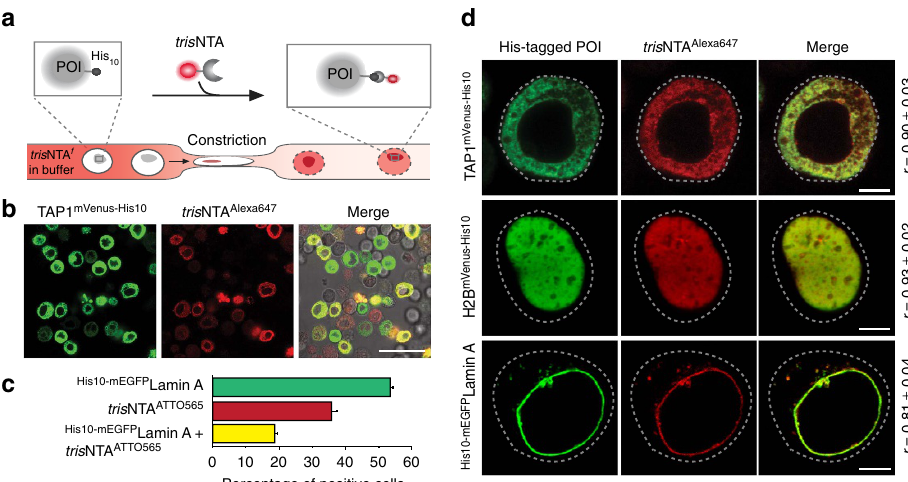
Figure 2 | Live-cell labelling of protein assemblies in distinct subcellular compartments. ( a ) Delivery of tris NTA f into living cells by microfluidic cell squeezing. Cells are pressed through micrometre constrictions of a microfluidic device, to introduce tris NTA f (bottom). Cell passage causes the formation of transient holes in the plasma membrane and enables tris NTA f transfer into the cytosol. His-tagged POI (grey) is specifically labelled by fluorophore- conjugated tris NTA ( tris NTA f , top), resulting in co-localization at the respective subcellular compartment. ( b ) High-throughput in-cell labelling of TAP1 mVenus-His10 -transfected HeLa cells by tris NTA Alexa647 imaged 10min after squeezing by CLSM. ( c ) Flow cytometry analysis of His10-mEGFP Lamin A- transfected HeLa Kyoto cells, after transduction with 100nM of tris NTA ATTO565 . Fluorescence intensity profiles of mEGFP and ATTO565 revealed that 20% of all cells were double positive for the His-tagged POI and tris NTA f . The error bars indicate the s.d. of three experimental replicates. ( d ) Specific labelling of His-tagged proteins in living cells at diverse subcellular localizations. tris NTA Alexa647 was delivered to cells and transfected with TAP1 mVenus-His10 (HeLa), His10-mEGFP Lamin A (Chinese hamster ovary (CHO-K1)) or H2B mVenus-His10 (HEK293) by squeezing. High target specificity of tris NTA Alexa647 is represented by excellent co-localization with the POIs (merge). Determined Pearson’s coefficients range from 0.81 to 0.93. Images were taken by CLSM 10min ( b ) or 1h ( d ) after squeezing. Dashed lines indicate the cell border. Scale bars, 50 m m ( b ), 5 m m ( d